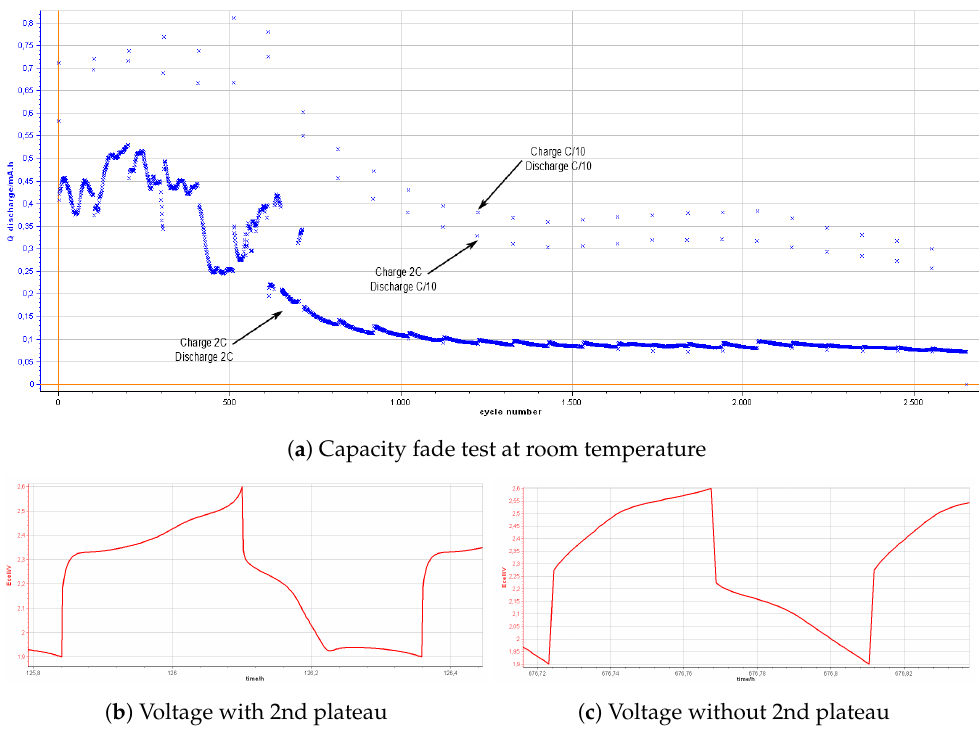
Figure 5. ( a ) Capacity fade. Detail of the voltage profile ( b ) with 2nd plateau and ( c ) without 2nd plateau.